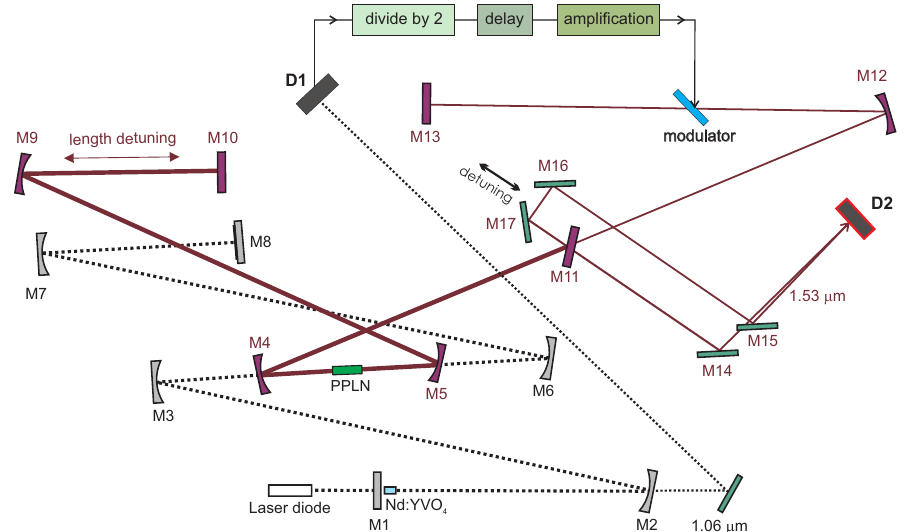
Figure 18. Diagram of diode-pumped modelocked Nd:YVO 4 laser with quasi-synchronous-pumped intracavity OPO. M1—flat mirror, M2—concave mirror ( r = 0.5m), M3, M6, M7—concave mirrors ( r = 0.3m), all HR @ 1.06 µ m, M8—semiconductor saturable absorber mirror (QW), PPLN crystal, M4,